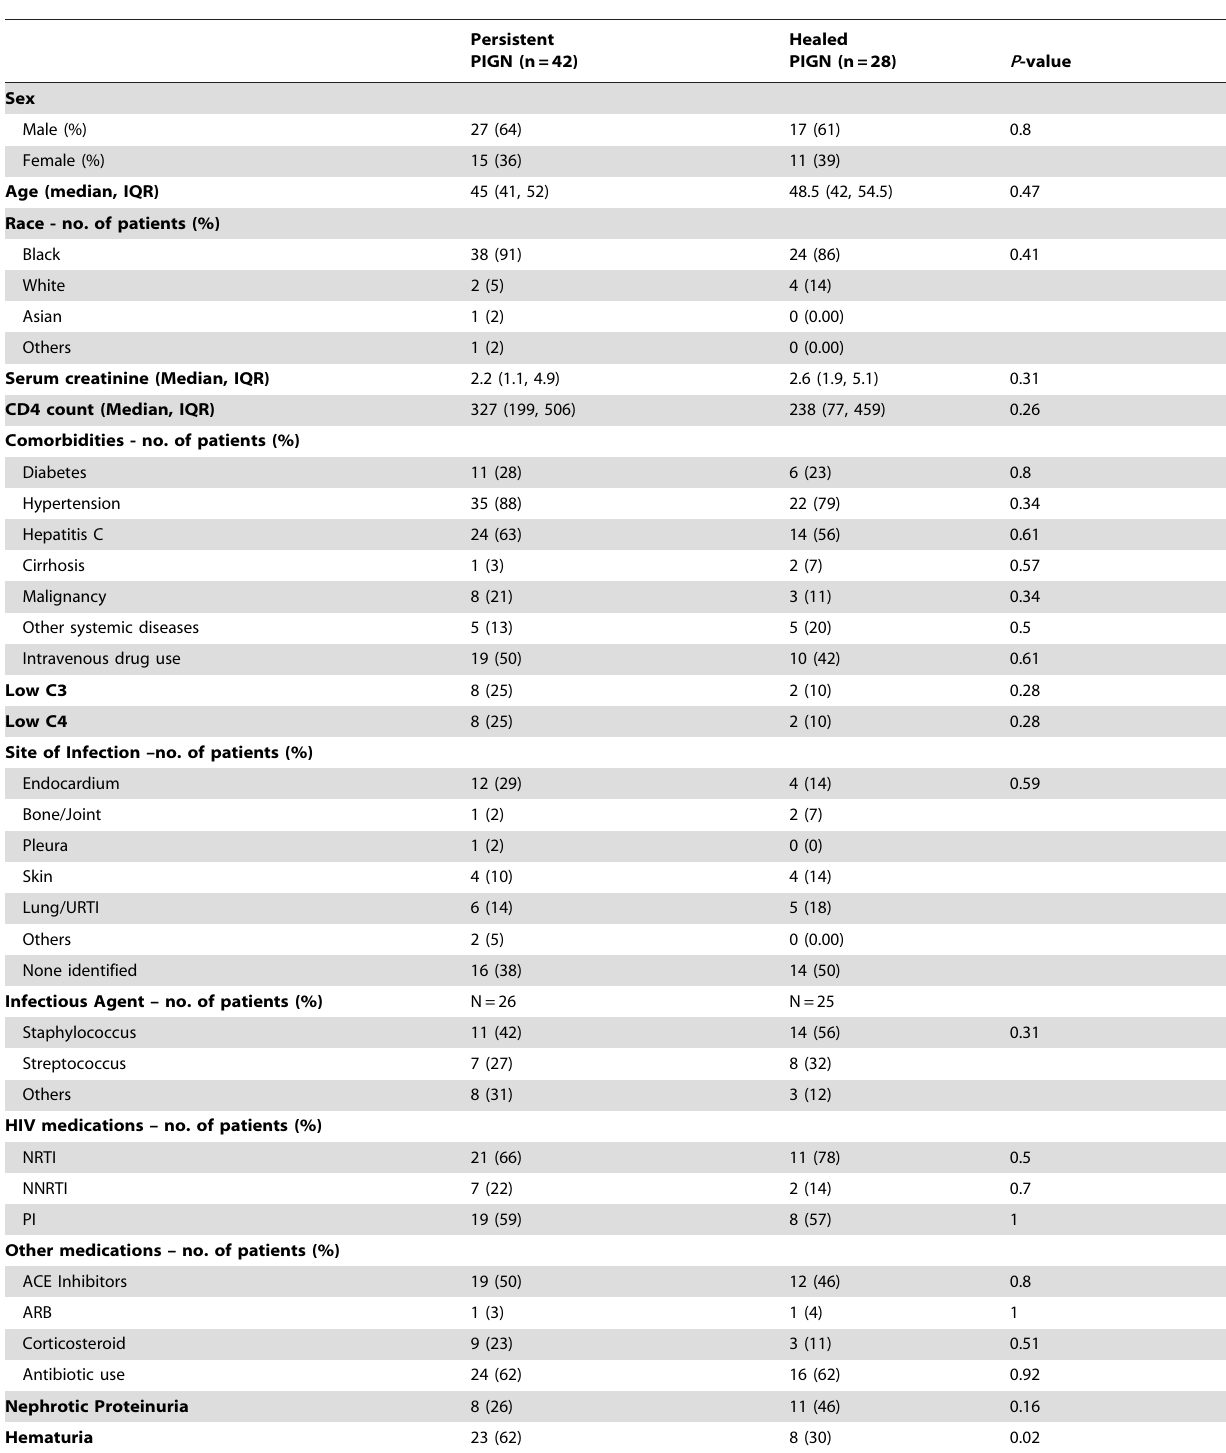
Table 2. Demographics, clinical characteristics and source of Infection of 71 patients at the time of diagnosis.